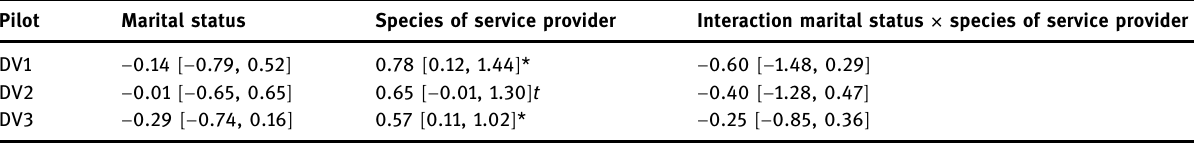
Table 1: Results of the pilot